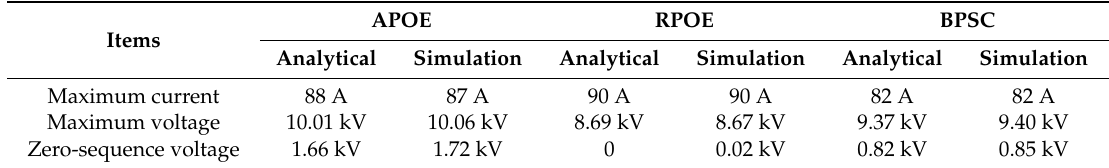
Table 2. Comparison between analytical results and simulation results.